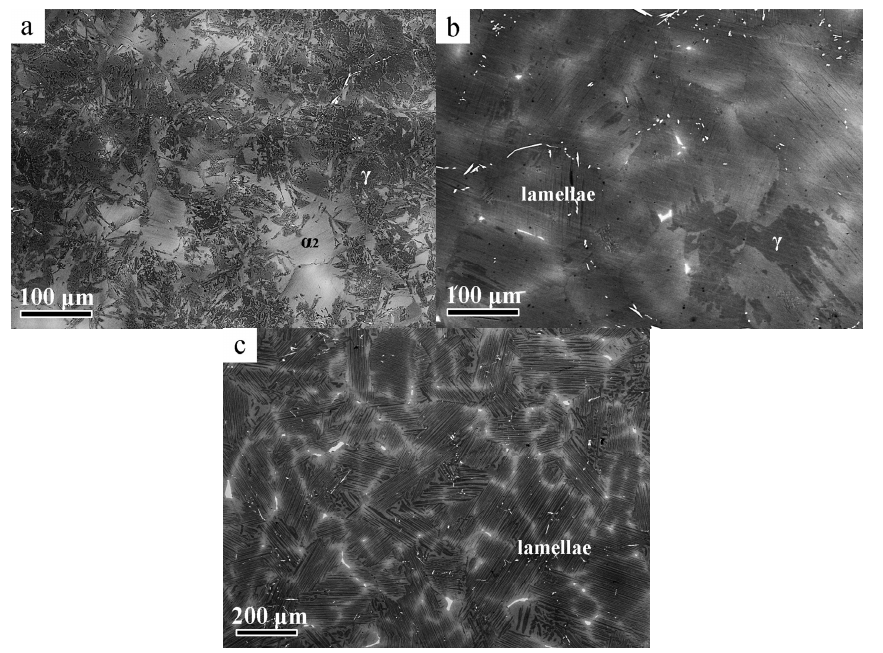
Figure 3. SEM images of the microstructures after cooling from 1340 °C by oil-quenching ( a ), air-cooling ( b ), and furnace-cooling ( c ).